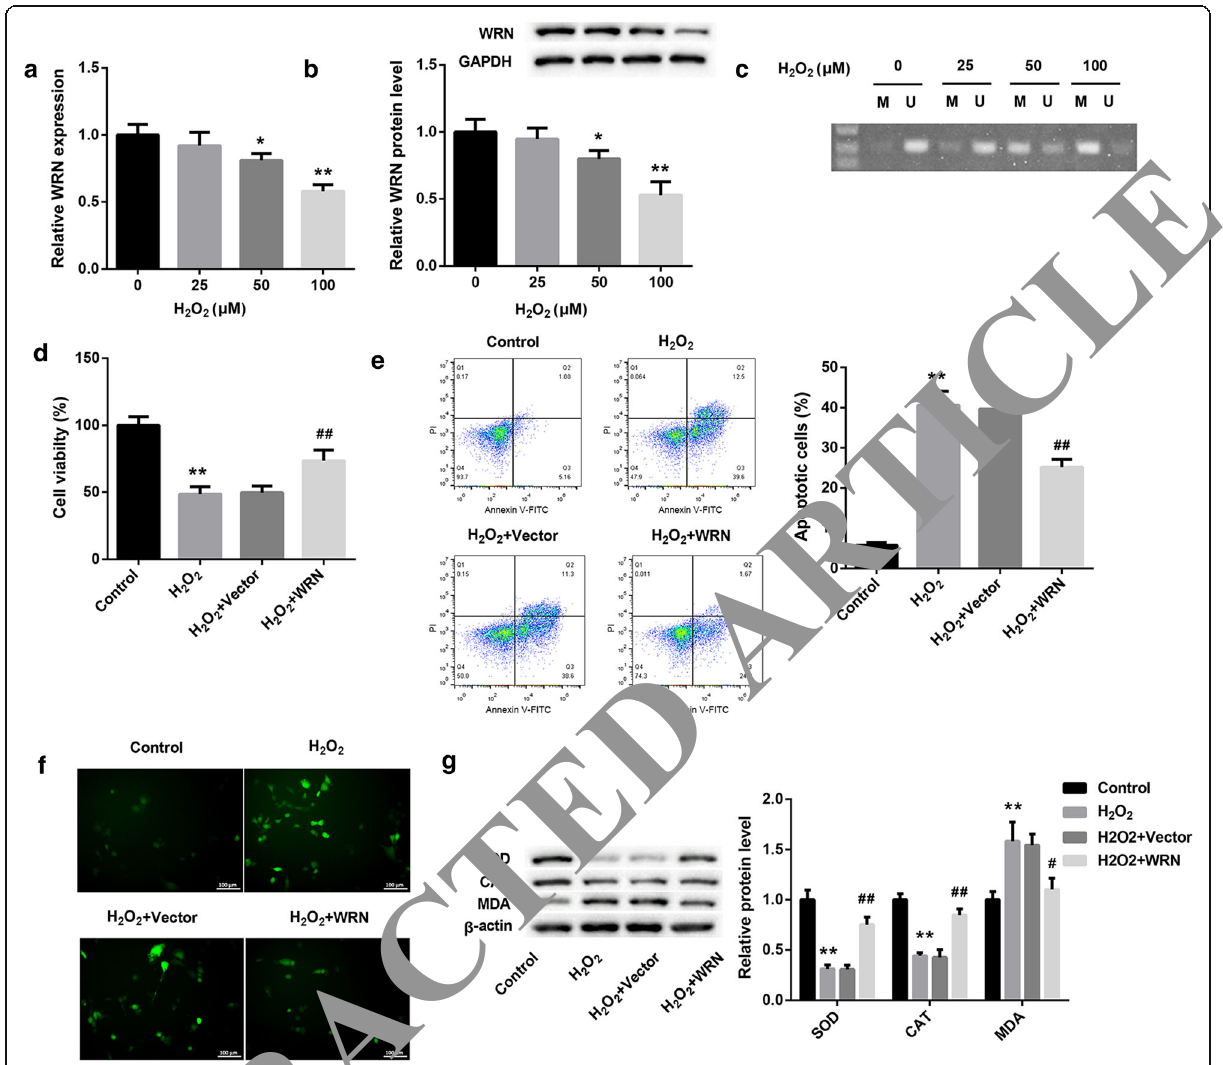
Fig. 2 WRN overexpression suppresses apoptosis and oxidative stress of SRA01/04 cells in vitro. SRA01/04 cells were treated with different concentrations (0, 25, 50 and 100 μ M) of H 2 O 2 . a QRT-PCR and ( b ) WB were performed to estimate the gene and protein expression of WRN in the SRA01/04 cells. c MSP was performed to detect the methylation level of WRN in the SRA01/04 cells. SRA01/04 cells were transfected with pcDNA3.1- WRN or pcDNA3.1-NC, and then the modified SRA01/04 cells were treated with 100 μ M H 2 O 2 . d CCK8 was performed to explore the cell proliferation of the modified SRA01/04 cells. e The apoptosis of the modified SRA01/04 cells was determined by flow cytometry. f The content of ROS in the modified SRA01/04 cells was detected by fluorescent probe DCFH-DA. g WB was performed to detect the expression of SOD, CAT and MDA in the modified SRA01/04 cells. M: methylation; U: unmethylation. ( * P <0.05 compared with the 0 μ M H 2 O 2 or Control group, ** P <0.01 compared with the 0 μ M H 2 O 2 or Control group, # P <0.05 compared with the H 2 O 2 +Vector group, ## P <0.01 compared with the H 2 O 2 +Vector